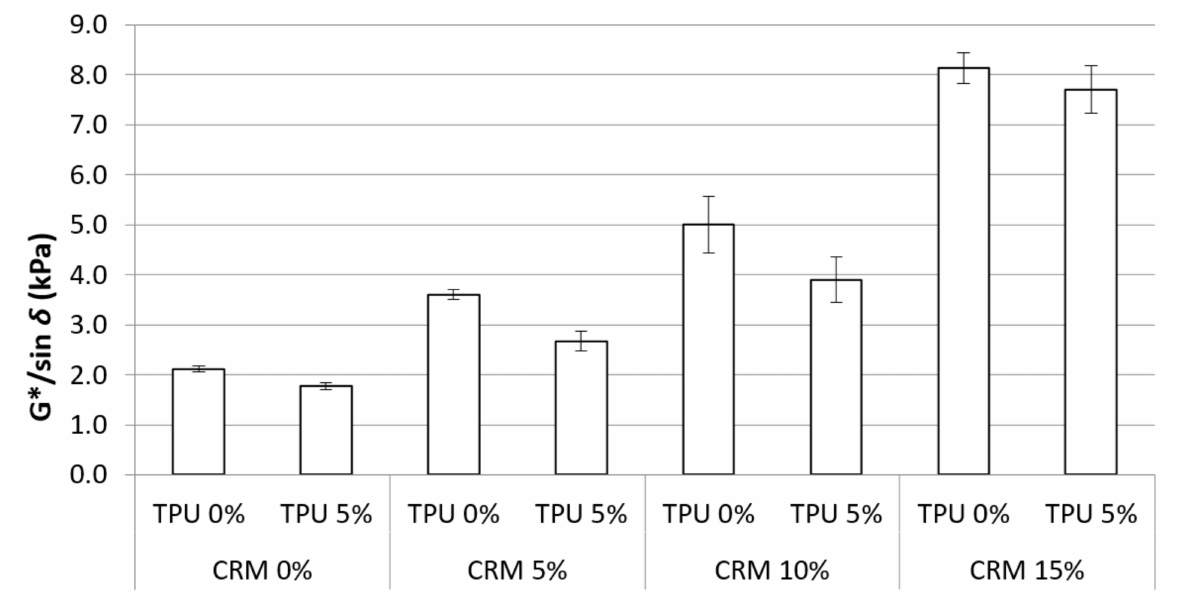
Figure 7. G*/sin δ of the asphalt binders containing CRM and TPU for RTFO conditions.